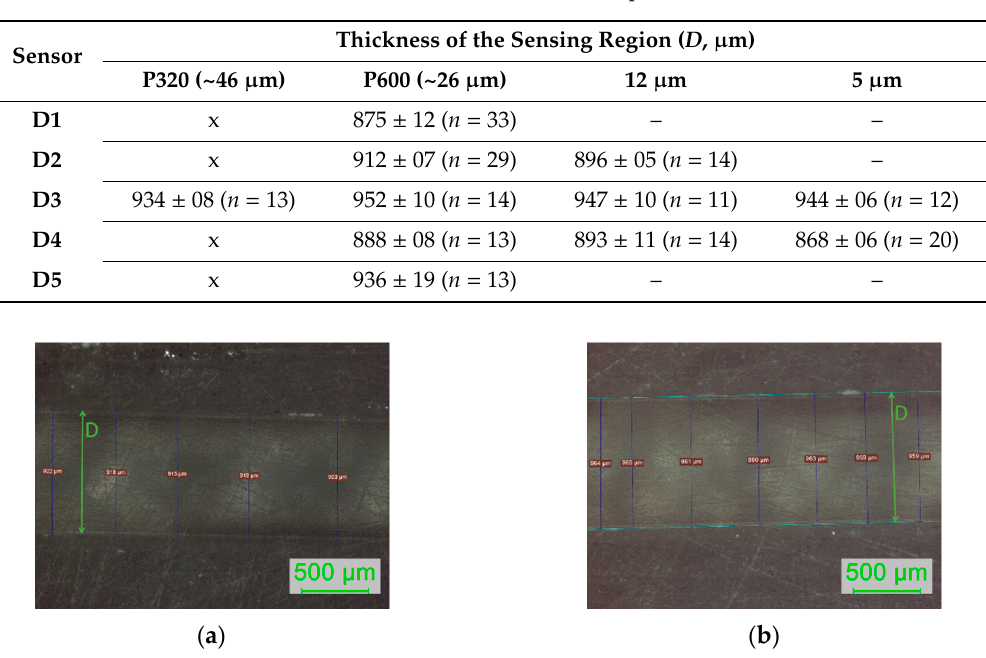
Table 3. D-shaped POF sensors: thickness of the sensing region after the polishing procedures, average value and standard deviation ( n is the number of measurements performed).